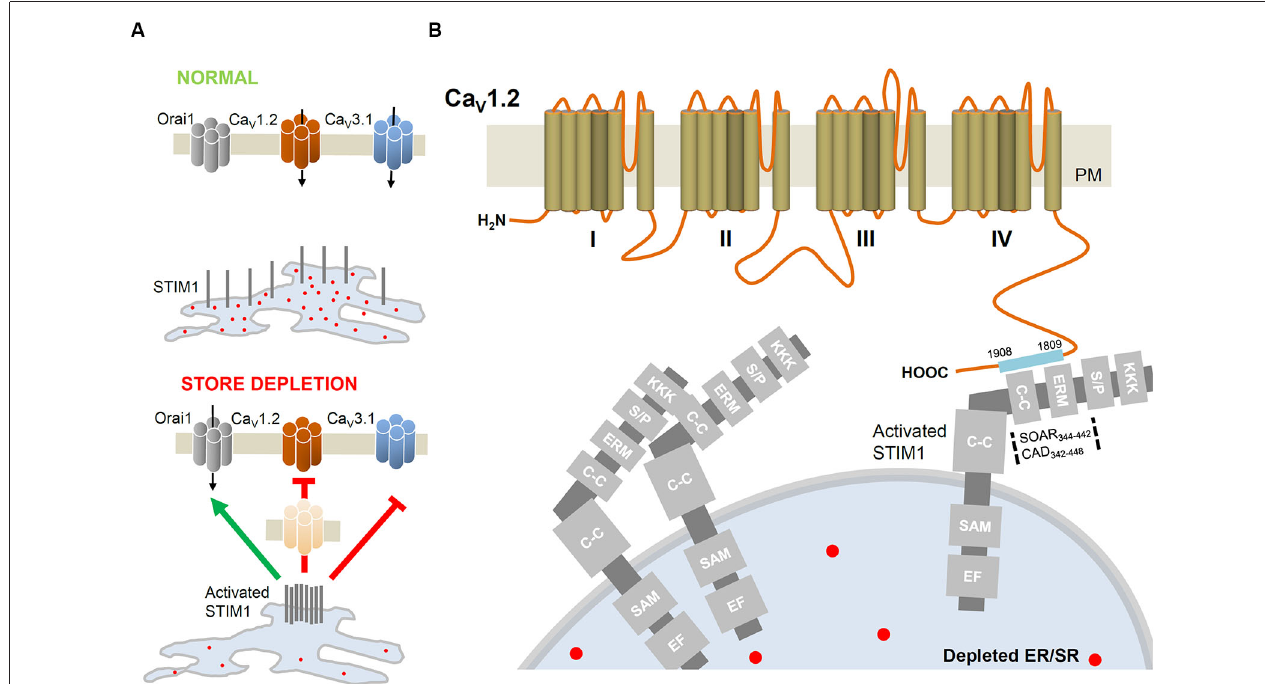
interacting sites of STIM1 and the C-terminus of Ca V 1.2. The STIM1 segments CAD (342–448; Park et al., 2010) or SOAR (344–442; Wang et al., 2010) interacts with the C-terminus (1809–1908; Park et al., 2010) of Ca V 1.2. C-C, coiled-coil domain; EF, EF hand motif; ERM, Ezrin-Radixin-Moesin domain; KKK, lysine rich domain; SAM, sterile- α motif; S/P, serine/proline rich